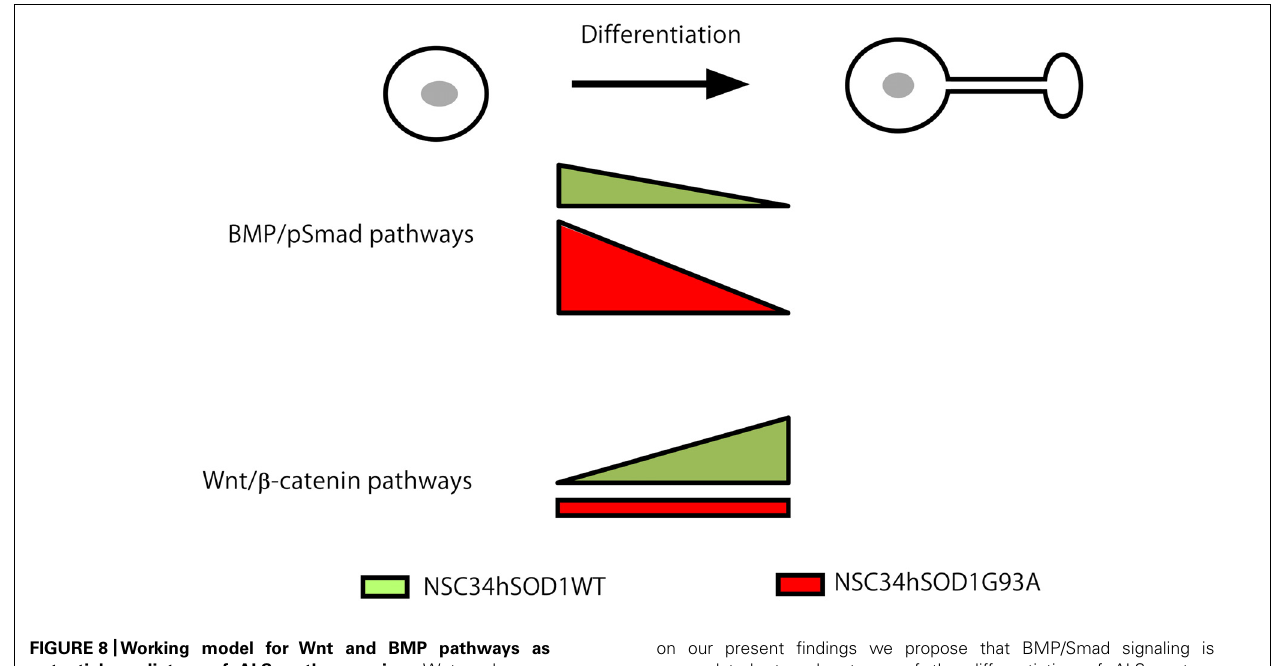
on our present findings we propose that BMP/Smad signaling is up-regulated at early stages of the differentiation of ALS motor neurons. In turn, the differentiated cells display an impaired ability to activate Wnt/ β -catenin